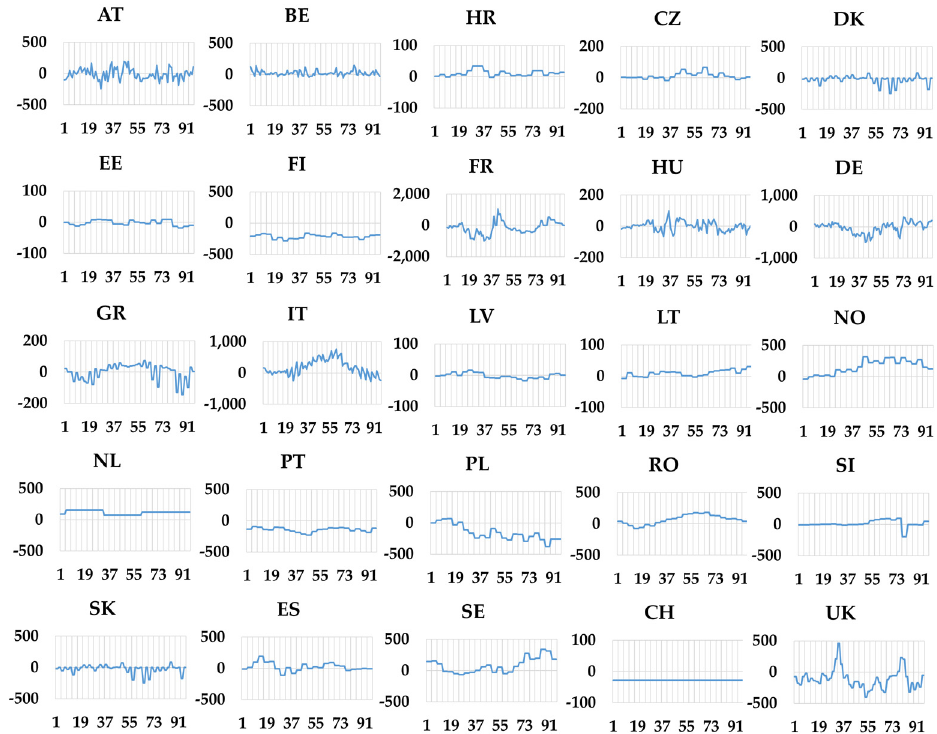
Figure 6. TSO mFRR needs in each participating control area included in the test